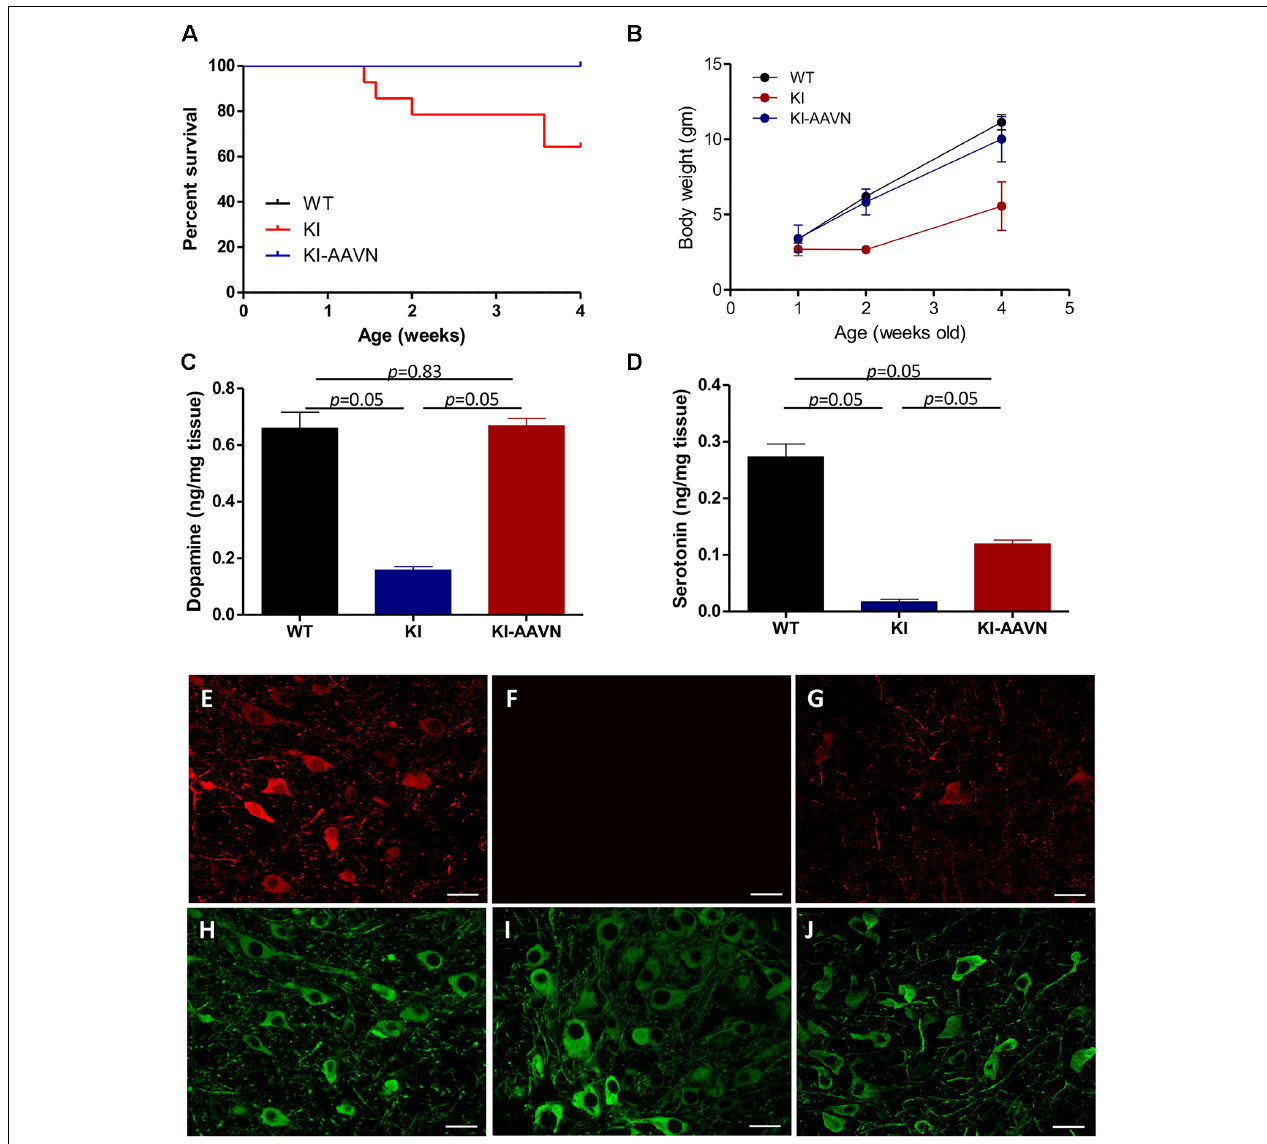
FIGURE 1 | Survival and body weights of the wild-type (WT), Ddc KI (KI), and AAVN-Aromatic L -acid decarboxylase (AADC)-treated KI (KI-AAVN) mice. (A) Kaplan-Meier survival curves showing the improved survival of the KI-AAVN mice (WT n = 12, KI n = 13, KI-AAVN n = 12). (B) The body weight plot shows that the KI-AAVN mice exhibited catch-up growth at 4 weeks of age (WT n = 9, KI n = 5, KI-AAVN n = 5). (C) Dopaminergic (DA) levels in the brains of the WT, KI, and KI-AAVN mice ( n = 3 each group). The p between WT and KI-AAVN is 0.83 ( U = 4), while p between other groups are p = 0.05 ( U = 0). (D) Serotonin levels in the brains of the WT, KI, and KI-AAVN mice ( n = 3 each group). For Figure 1D , p is 0.05 between all three groups while U = 0. (E–J) Immunofluorescence staining for AADC (red) and TH (green) in coronal brain sections from 4-week-old WT (E,H) , KI (F,I) , and KI-AAVN (G,J) mice.